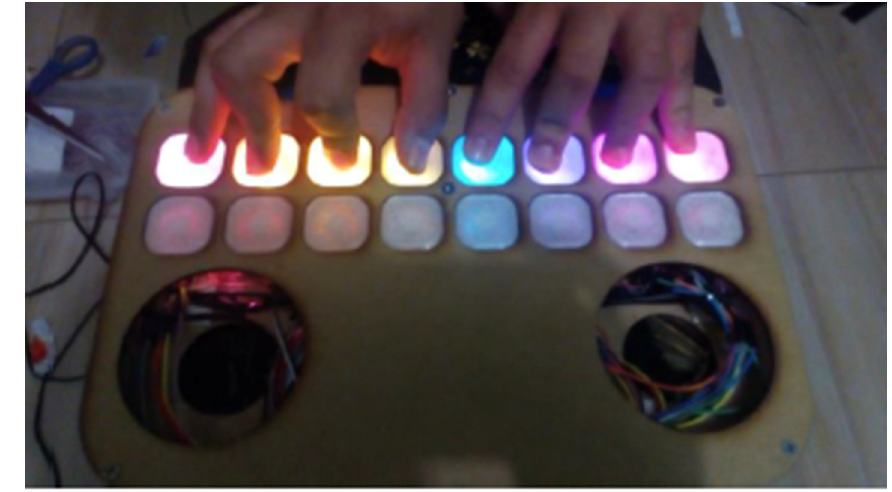
Figure 8. CASETO System.